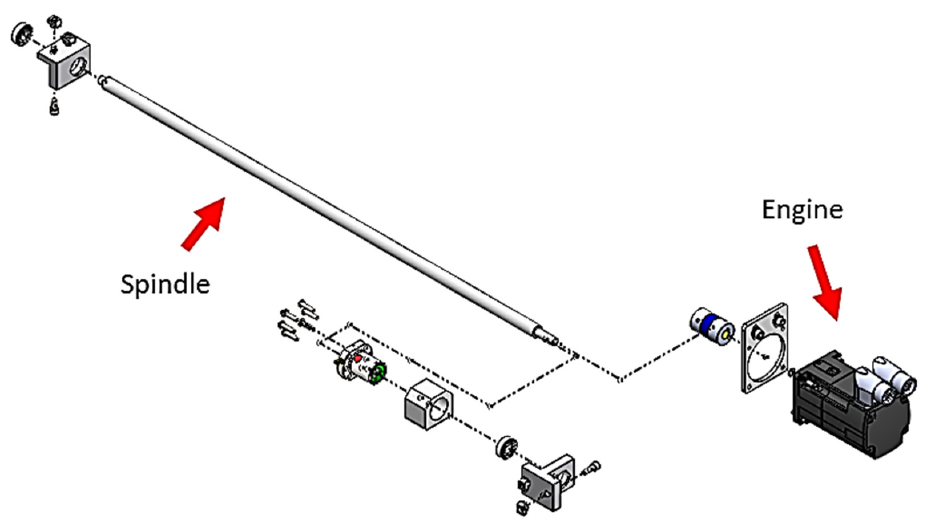
Figure 18. Spindle assembly’s exploded view.